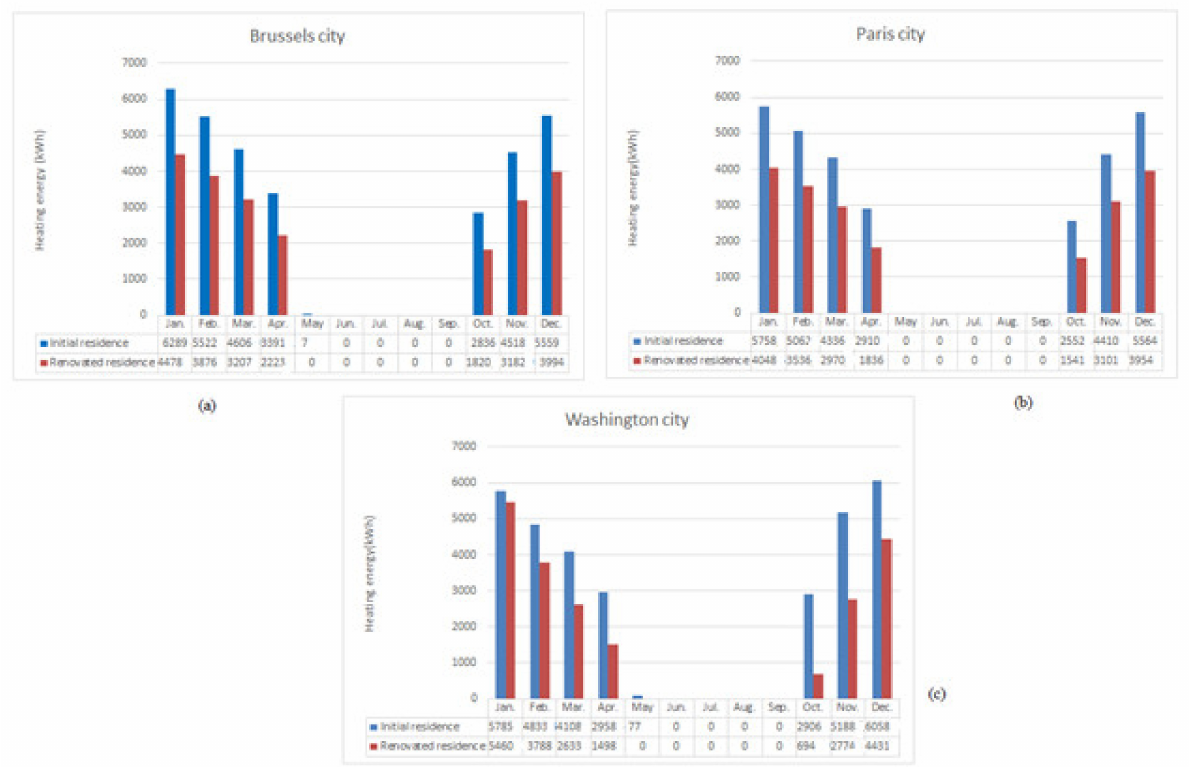
Figure 7. Heating energy in Brussels ( a ), Paris ( b ), and Washington DC ( c ).